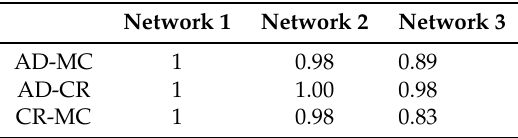
Table 2. Comparison of the analysis results of the MDND on the three networks with the administrative divisions and community detection algorithm.